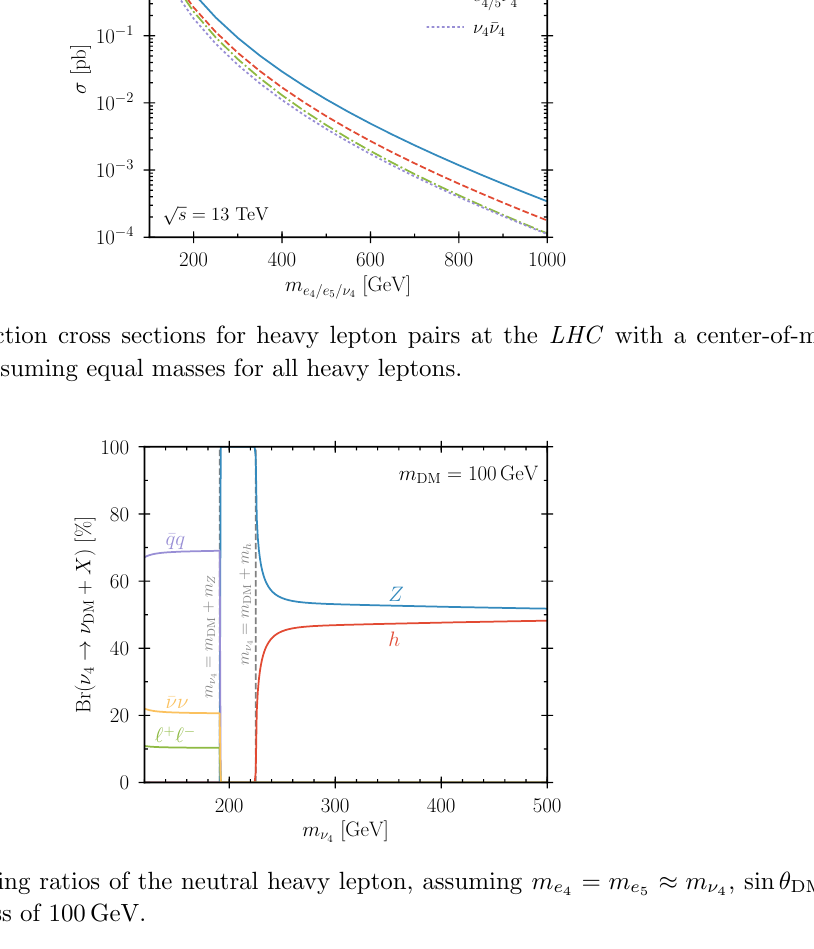
= m e m (cid:23) , sin (cid:18) DM = 4 5 (cid:25) 4